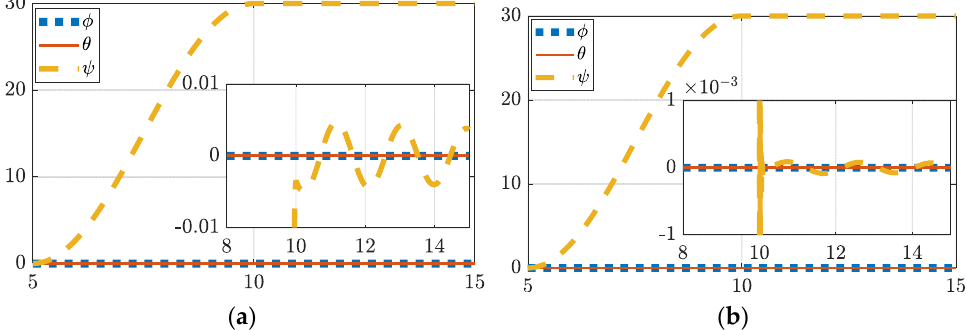
Figure 3. Control with perturbations. ( a ) Thirty degree yaw using feedforward plus feedback (FFD + FB) control; ( b ) thirty degree yaw hybrid deterministic artificial intelligence control. Both figures include display of tracking errors in the zoomed-inset graphic. Notice the ordinate scale, respectively of insets in subfigure ( a , b ) to reveal the relative comparison.